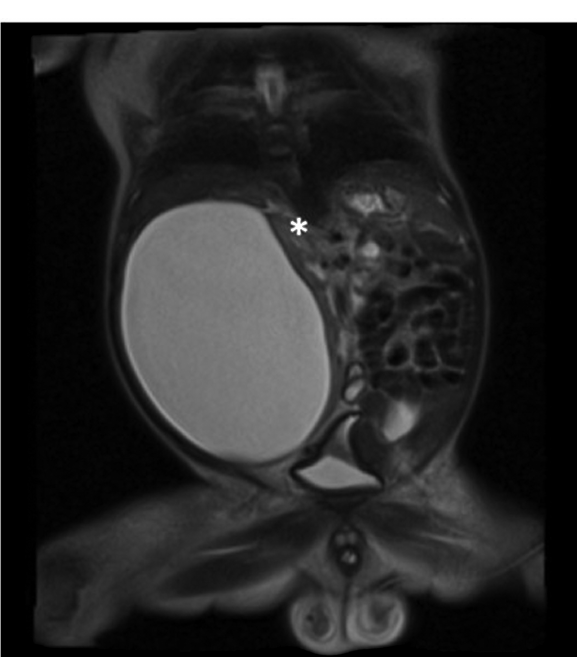
Fig. 2 Magnetic resonance imaging at second day of life, asterisk indicating upper pole of right